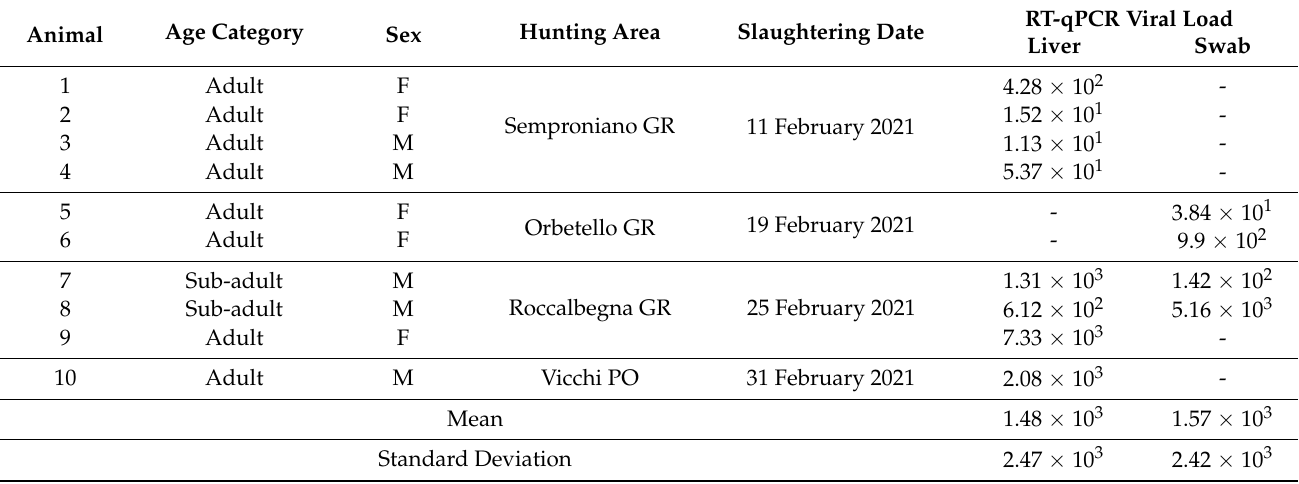
Table 1. Molecular results of positive wild boar liver and